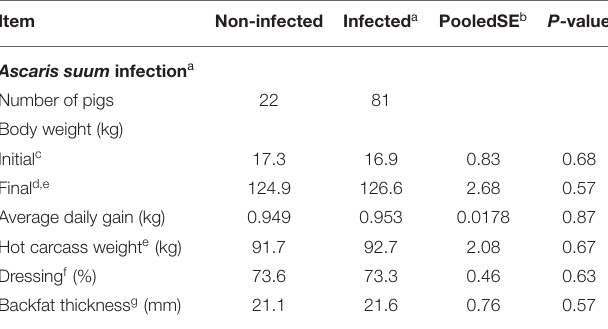
TABLE 3 | Growth performance and carcass traits of pigs infected vs non-infected with Ascaris suum .